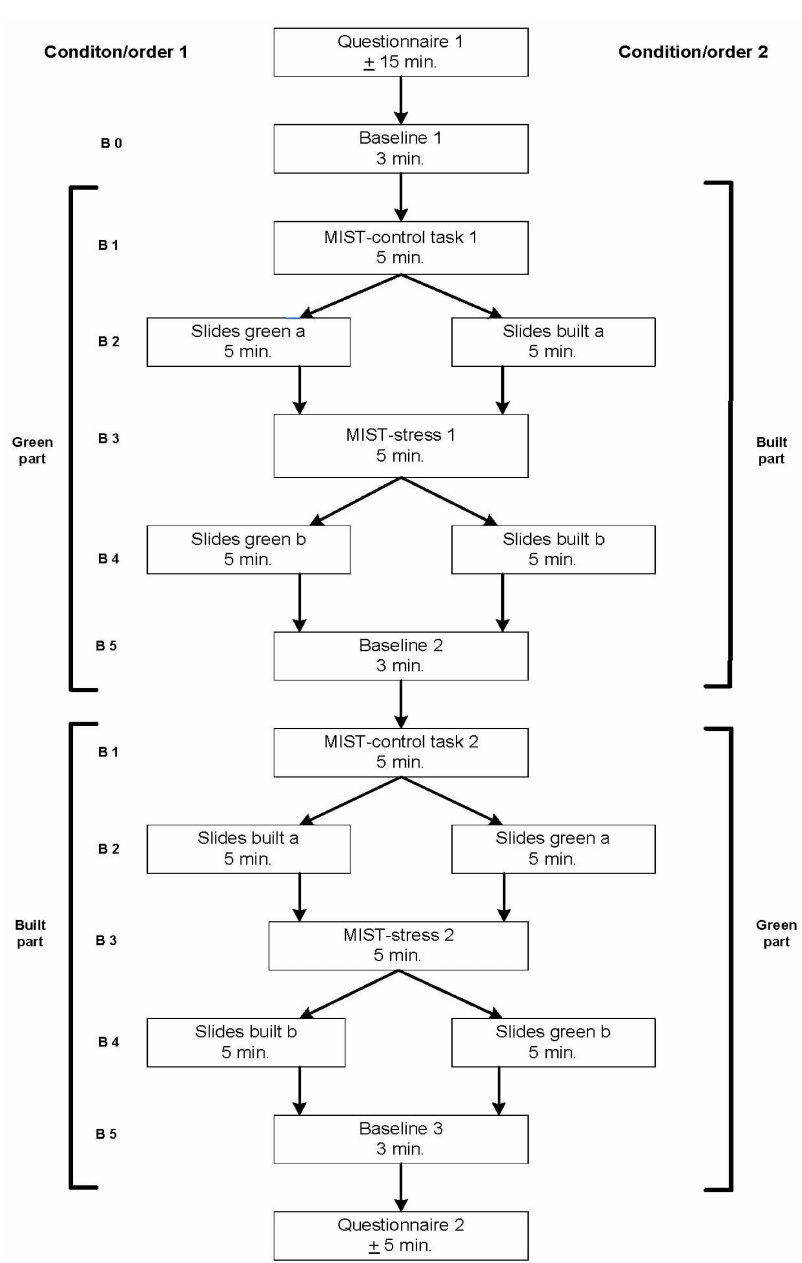
Figure 2. Design of the